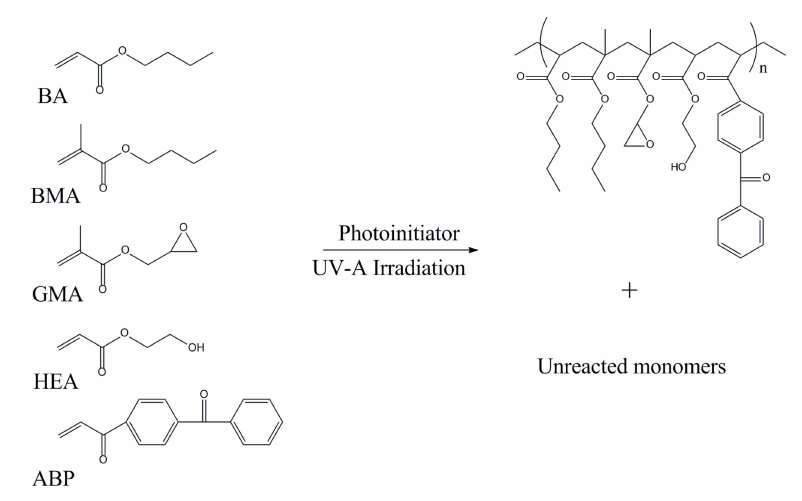
Figure 1. Chemical structures of monomers and synthesis of acrylic syrups.